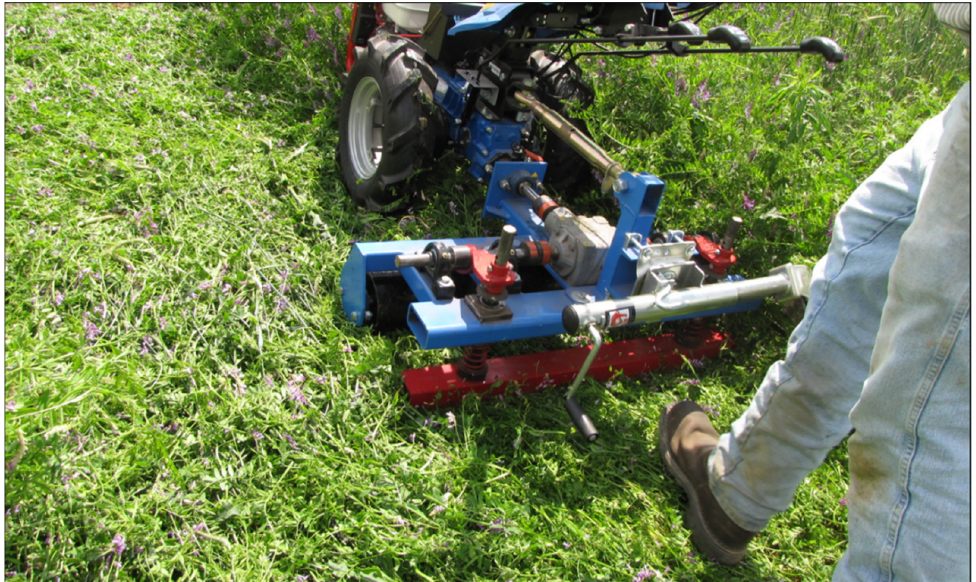
Figure 4. Powered roller-crimper (Kornecki, 2012, US patent # 8176991 B1) in hairy vetch. [24]; US patent #7987917 B1.